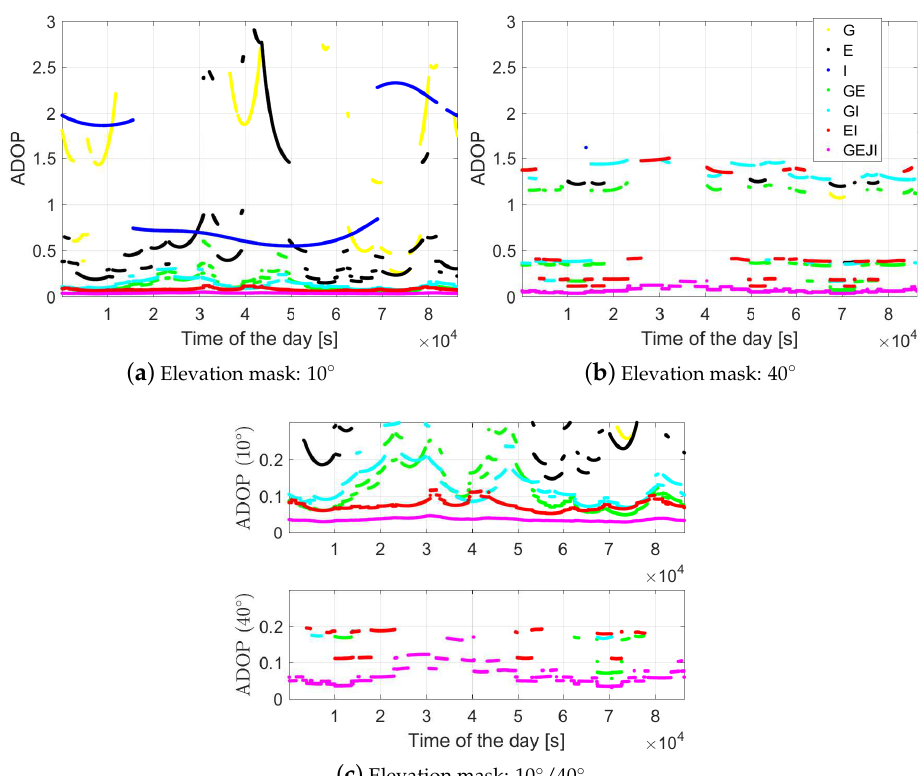
Figure 5. ADOP (Equation (10)) of baseline CUAA-CUCC on DOY 224, 2018 with elevation masks of 10 ( a ); 40 degrees ( b ) and the figures zoomed out for small ADOP values ( c ). The data sampling rate is 1